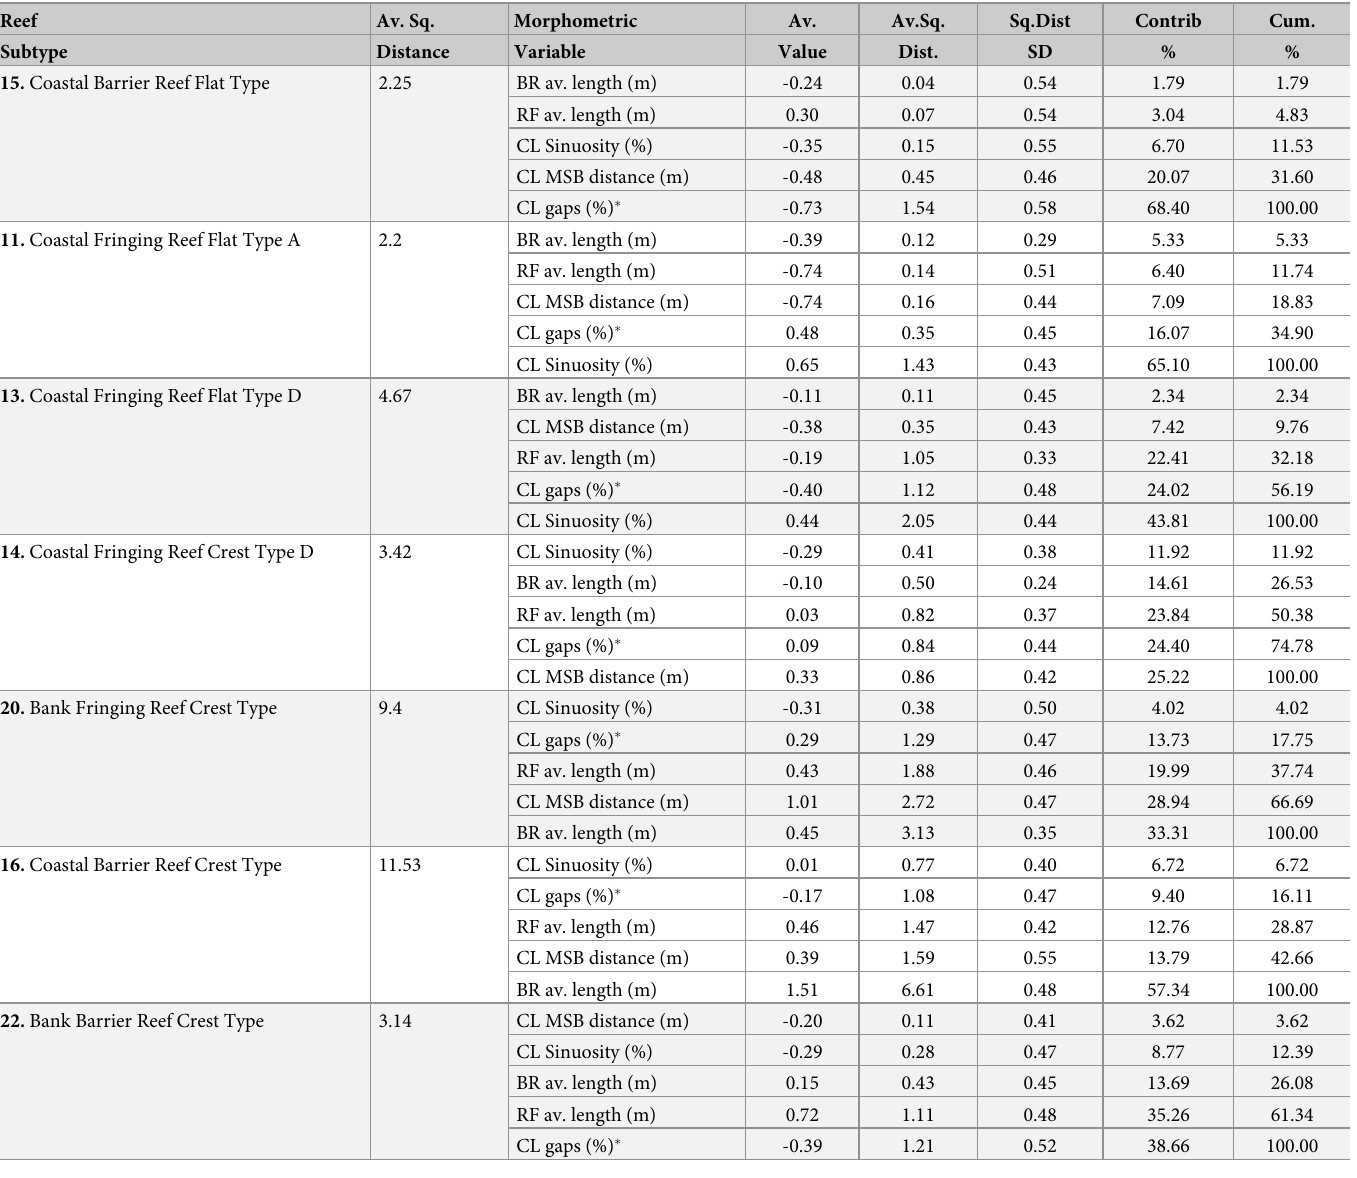
Table 3. Relative contribution of morphometric parameters to common reef subtypes. Reef Av.